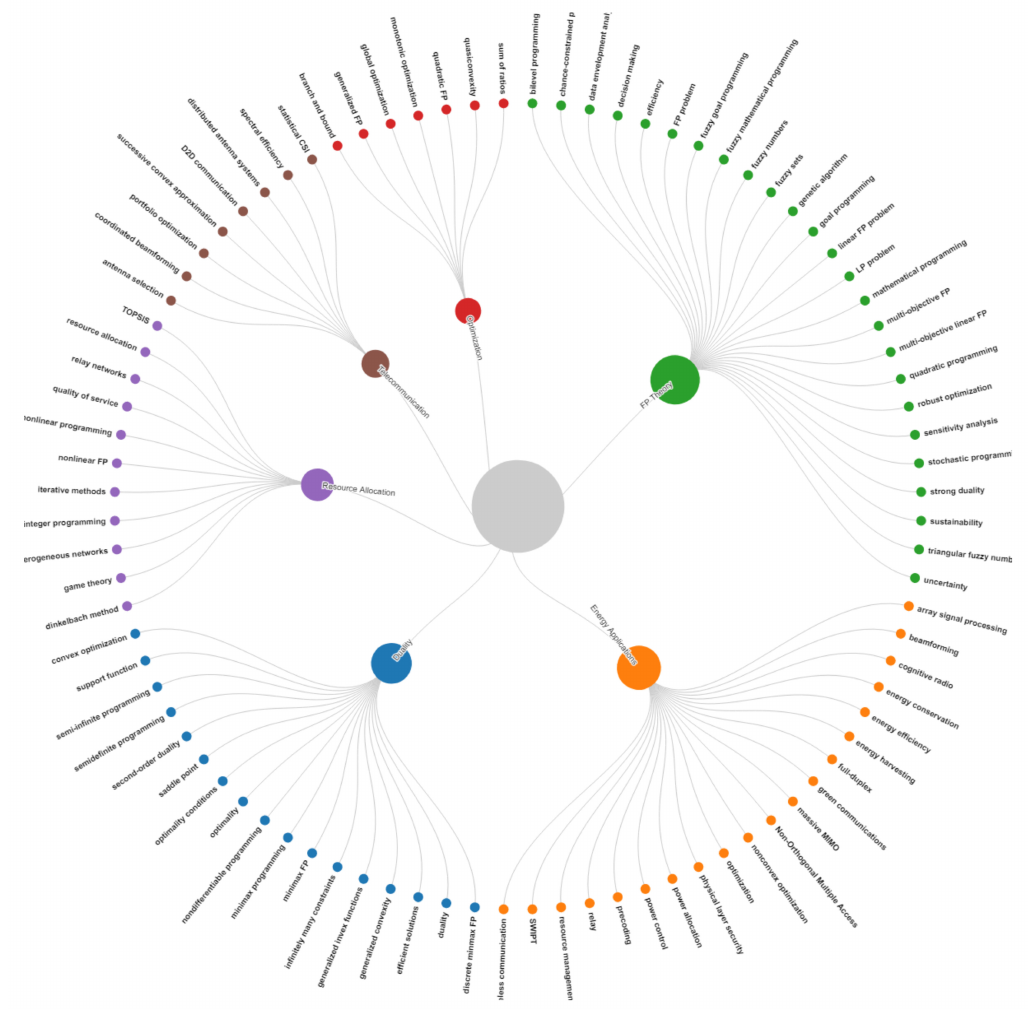
Figure 9. Author keywords co-occurrences network, n >